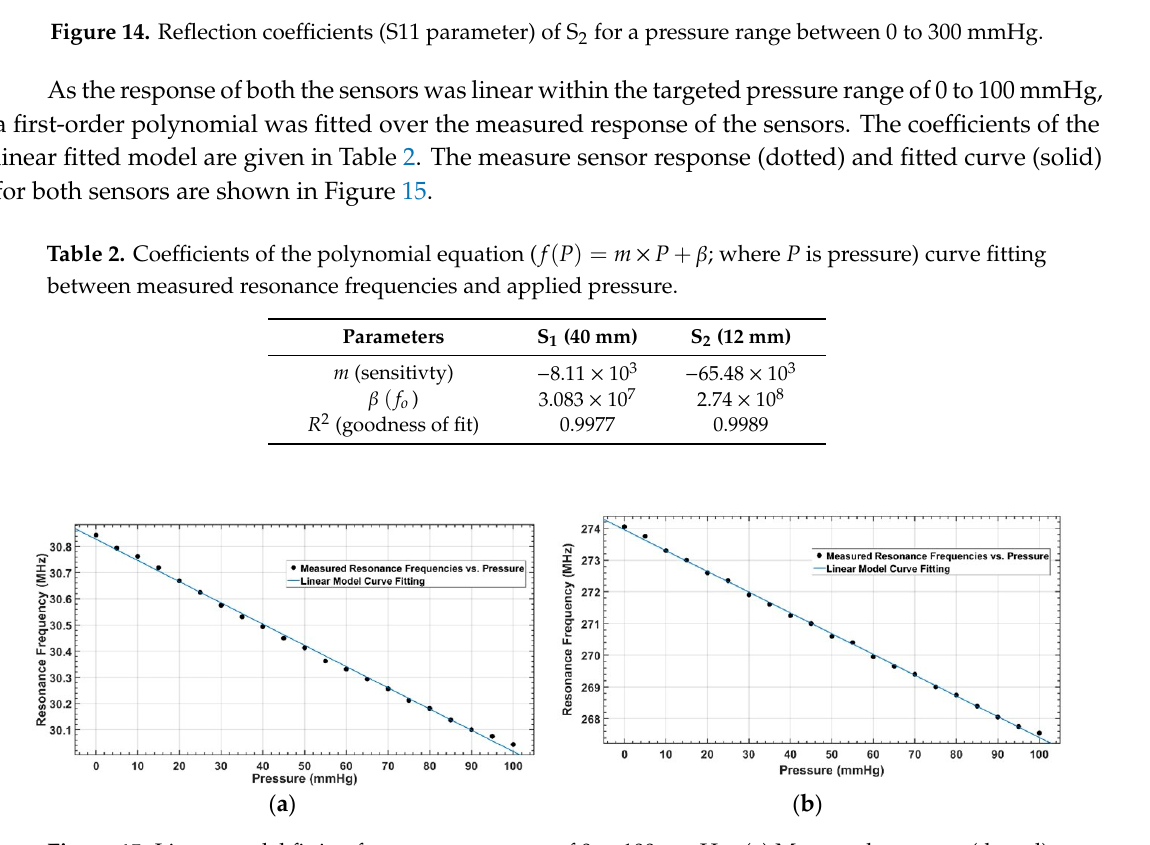
Figure 15. Linear model fitting for a pressure range of 0 to 100 mmHg: ( a ) Measured response (dotted) and linear fit (solid) of S 1 ; ( b ) Measured response (dotted) and linear fit (solid) of S 2 . In the sensor response over a wide range of pressure up to 300 mmHg, a nonlinearity, associated with compression saturation of the dielectric layer, was observed at higher pressures as shown in Figure 16. Therefore, a second-order polynomial function was fitted to the measured response to